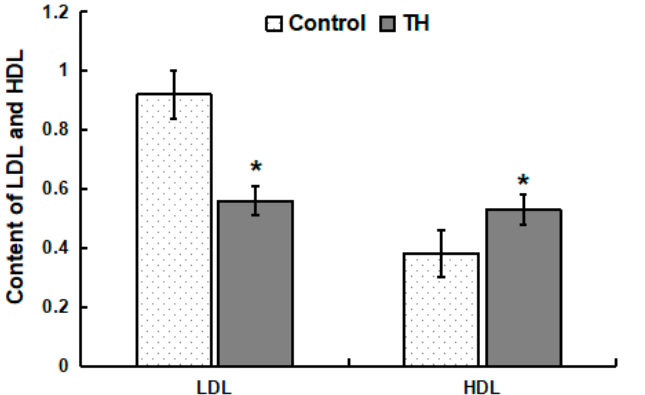
Figure 1. Content of LDL and HDL in plasma. Values are means ± SD, n = 6. * Means are significantly different from the control group ( p < 0.05).